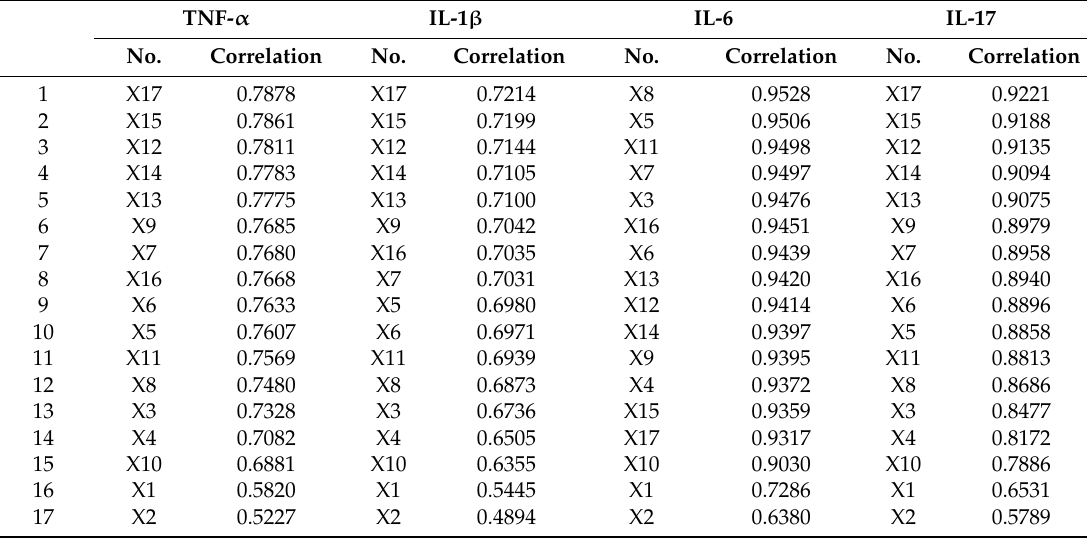
Table 9. The results of GRA between 17 characteristic peaks and sera